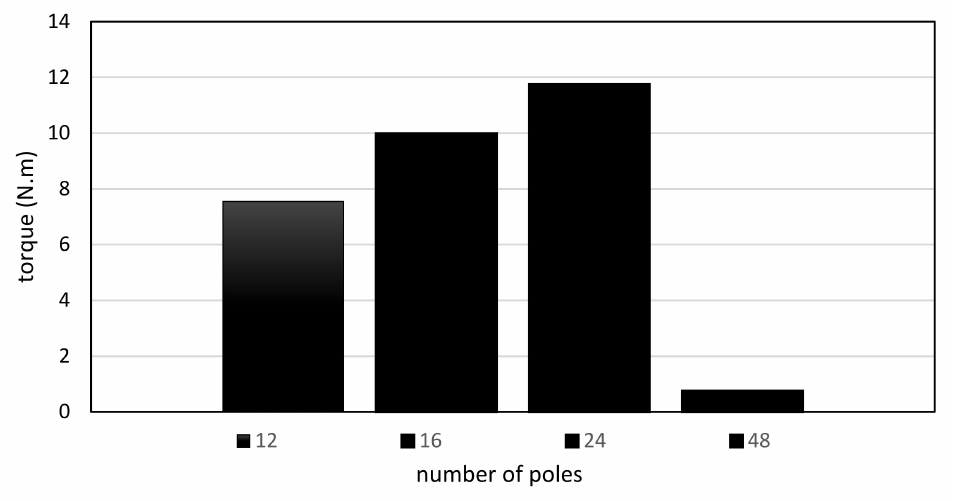
Figure 11. Torque changes vs. pole number at rotational speed of 100